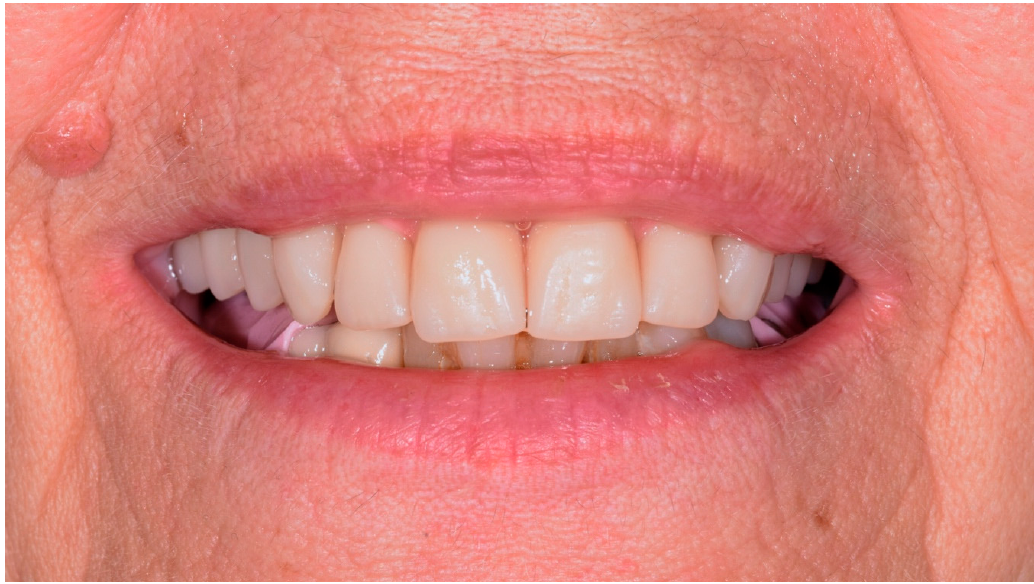
Figure 20. The smile of the patient.